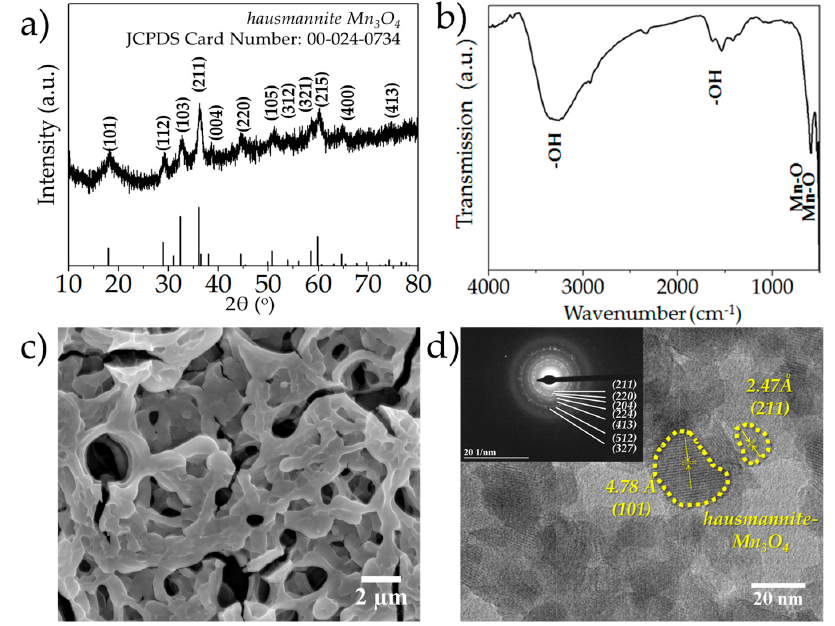
Figure 1. ( a ) XRD pattern of the as-deposited MnO x powders; ( b ) FTIR pattern of the as-deposited MnO x films; ( c ) SEM microstructure of the as-deposited MnO x films; ( d ) HRTEM micrograph of the as-deposited MnO x powders; the inset depicts the SAED pattern.